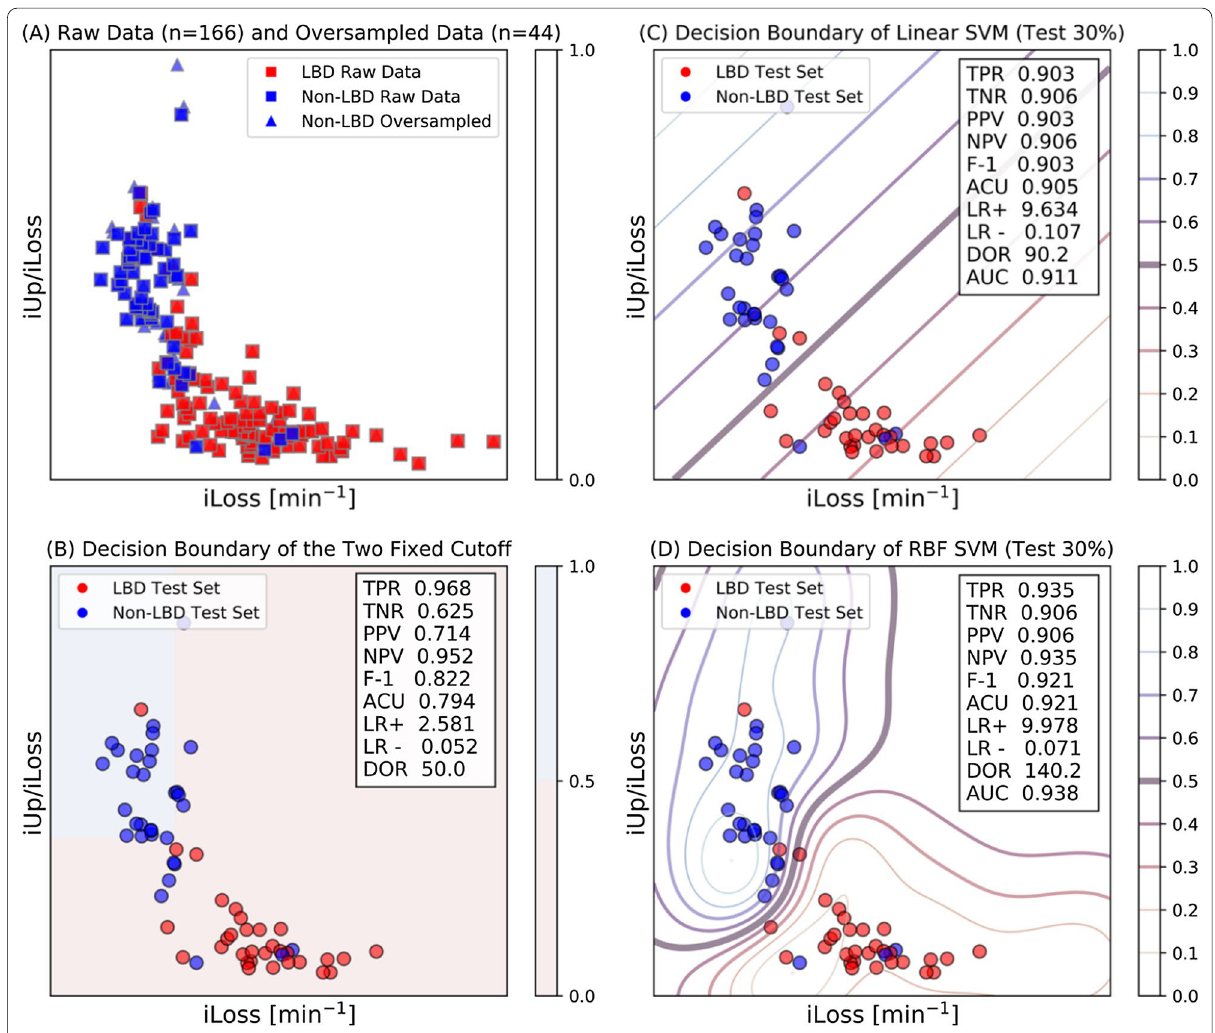
Fig. 5 Representative results of machine learning classifier models for iLoss and iUp/iLoss to discriminate patients with Lewy body disease (LBD) from those with non‑LBD. After correction for class imbalance using SMOTE, 210 coordinates of iUp and iUp/iLoss, which represent 105 LBD patients (squares in red) and 105 oversampled non‑LBD patients (squares and triangles in blue), are shown ( A ). An example portion allocated for testing (63 samples, 30%) is shown with the independent cut‑off values of iLoss and iUp/iLoss ( B ). Decision boundaries (thick lines) and predicted probabilities (thin lines) were generated from single runs of the SVM classifier models with the linear kernel ( C ) and the radial basis function kernel ( D